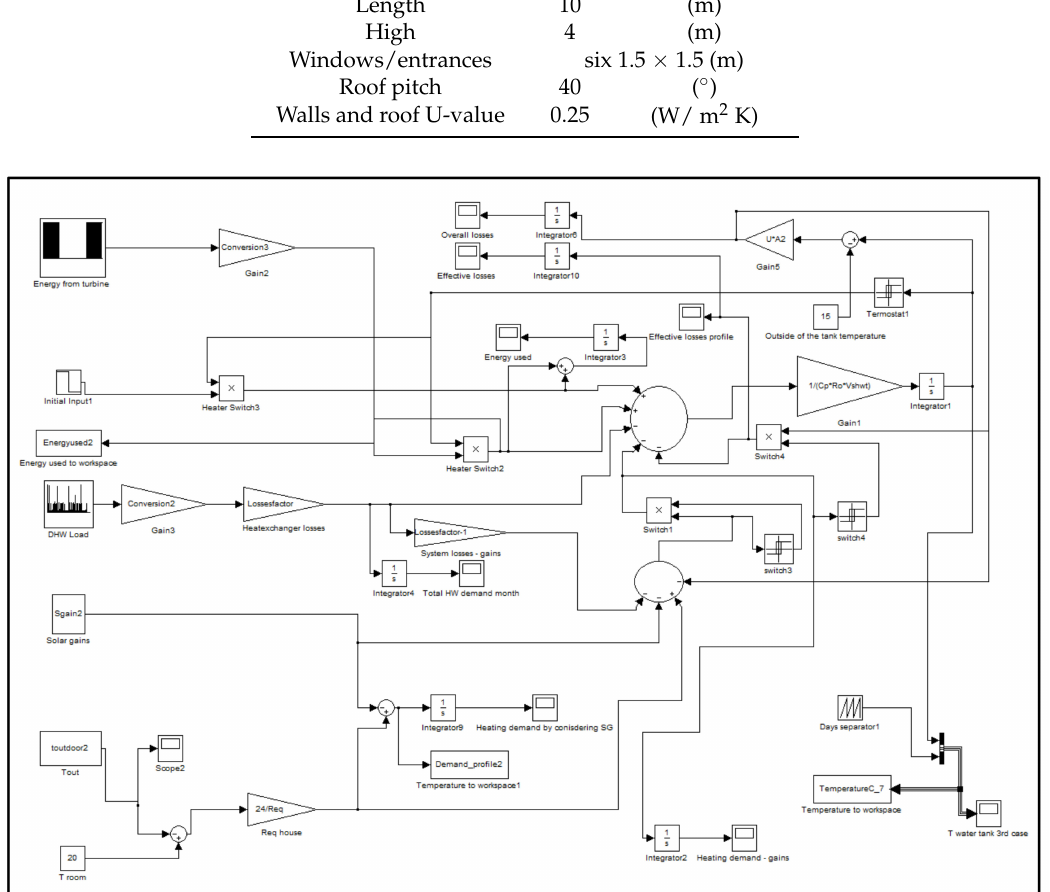
Figure 10. Matlab-Simulink model created for investigating the feasibility of the third scenario